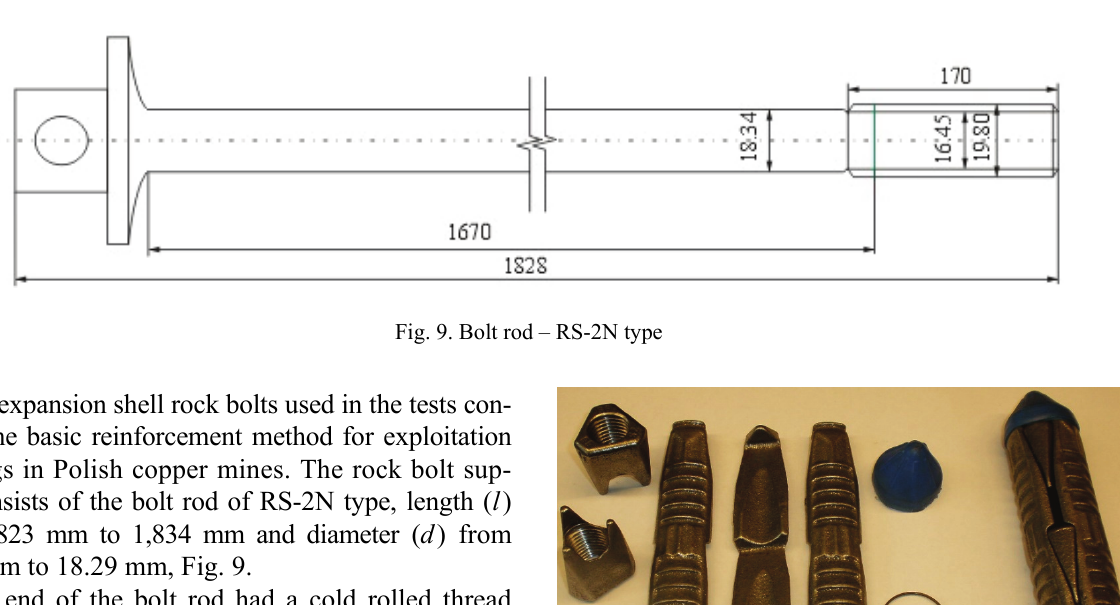
Fig. 8. Split bushings filled with concrete